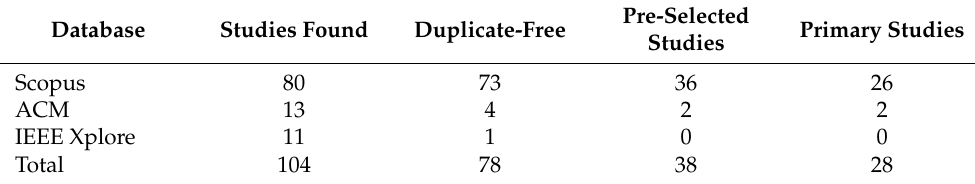
Table 6. Number of remaining studies after filtering the database